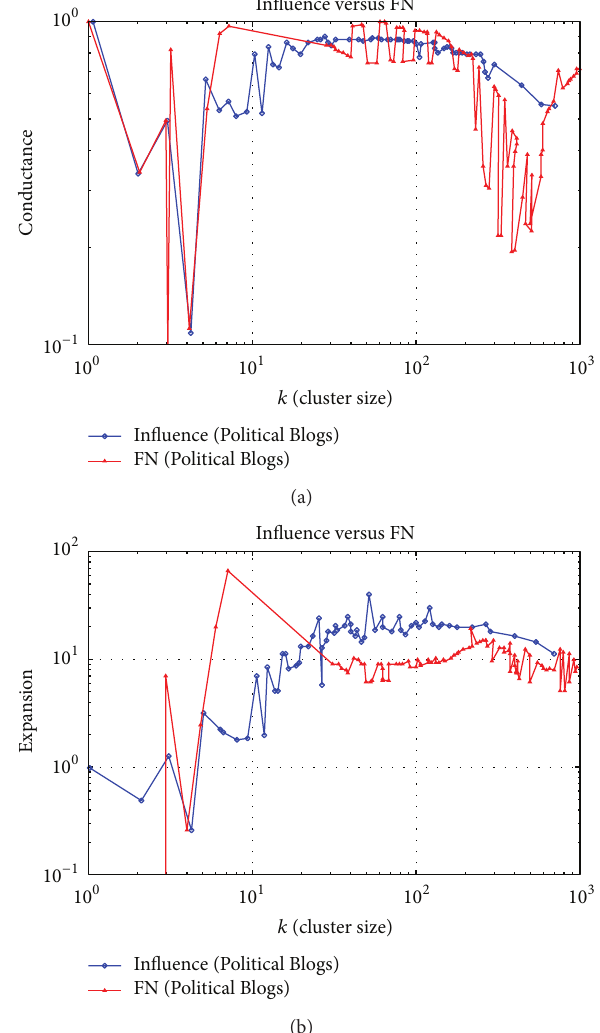
Figure 2: Evaluating values of the clustering effect of the Political Blogs